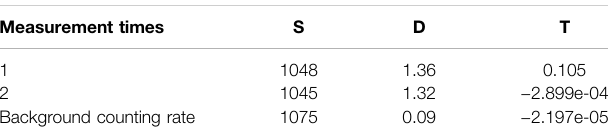
TABLE 9 | Sample 2 measurement.